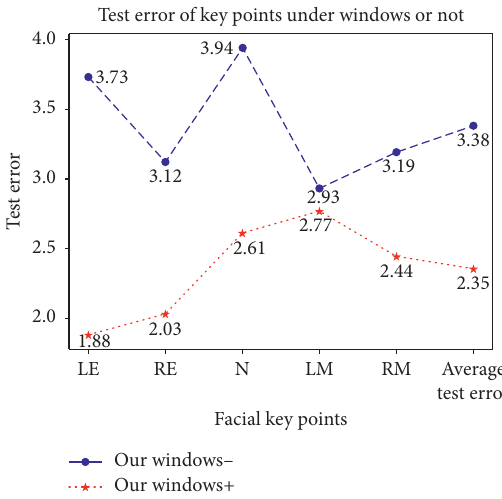
Figure 5: Test error graph of key points under windows or